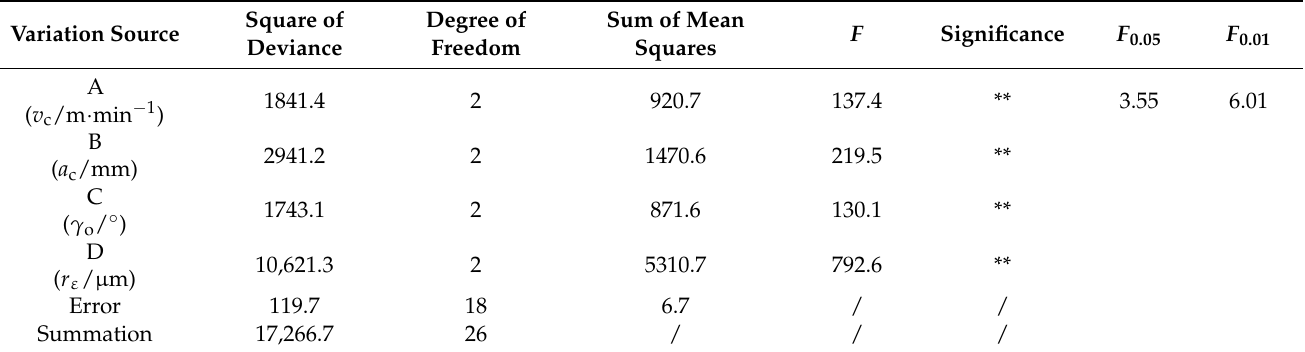
Table 6. Analysis of variance of cutting forces along the cutting